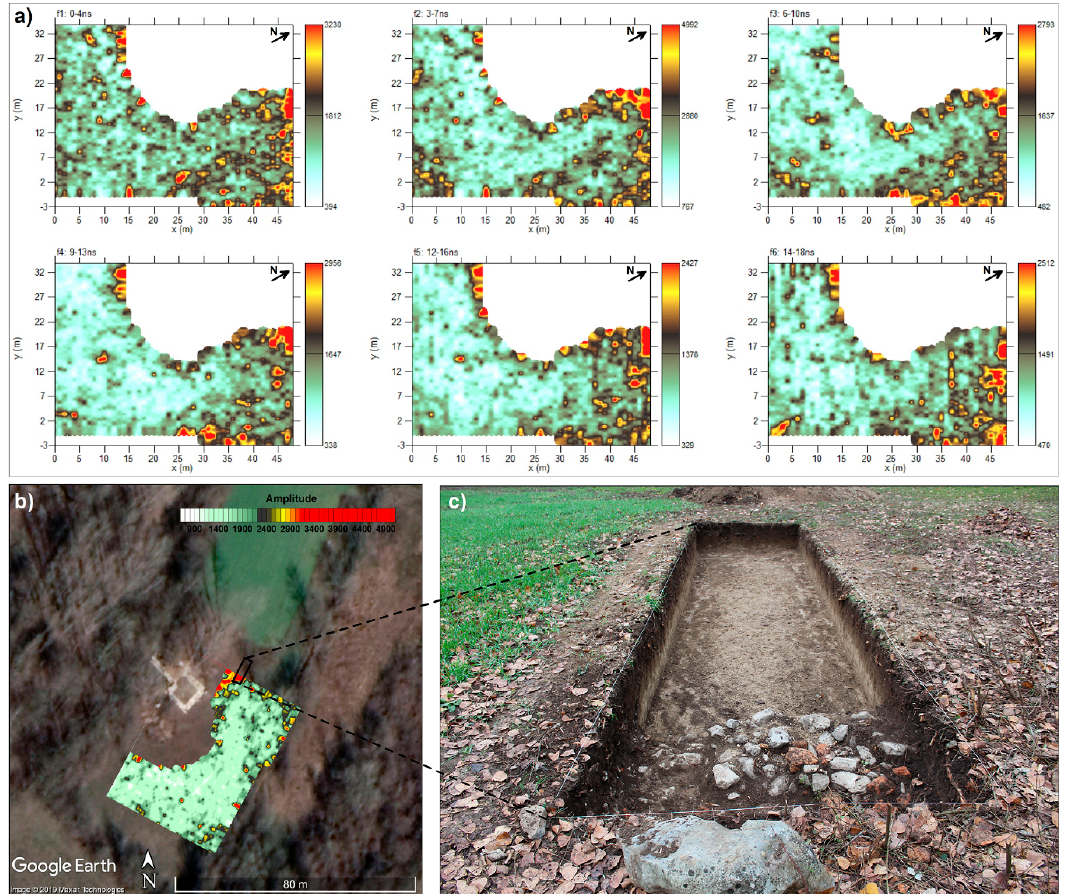
Figure 4. Mjace: GPR time slices in the range 0–18 ns ( a ), time slice relative to 9–13 ns overlapped on the satellite image of Google Earth TM ( b ) and the agglomeration of small stones and broken bricks brought to light by archaeological excavation ( c ).